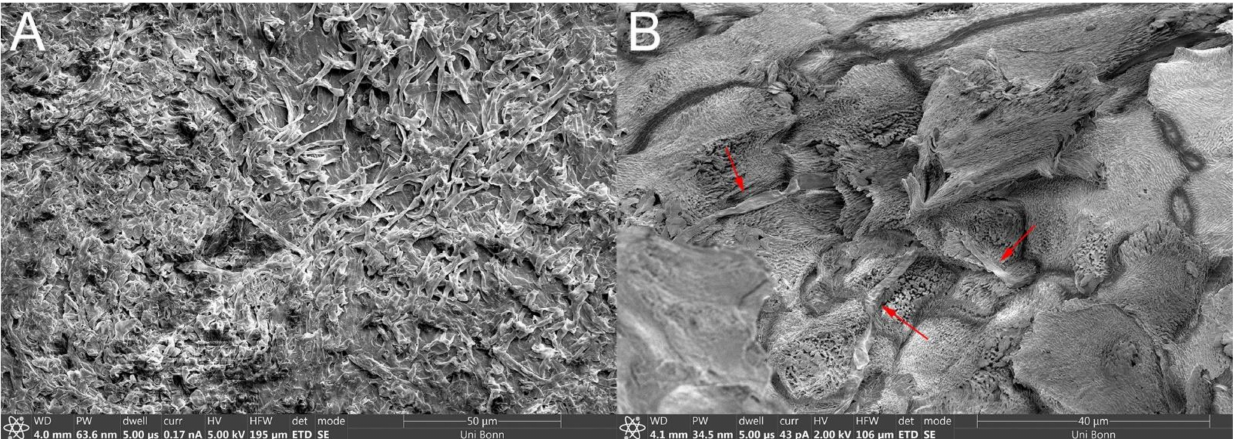
Figure 3. Scanning electron microscopy images of infected 400- µ m bovine hoof sheets: ( A ) dense growth of fungi over the entirety of the membrane surface, and a ( B ) cross-section fracture reveals fungal growth inside the membrane matrix, fungal hyphae, indicated by arrows.